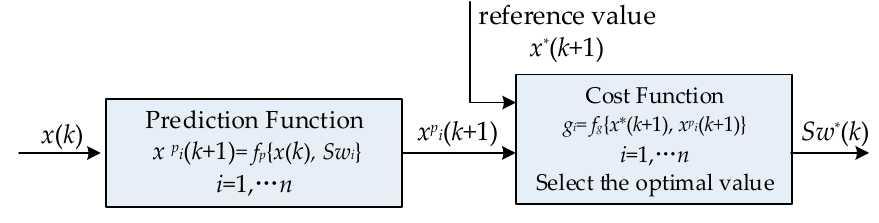
Figure 4. The basic principle of model predictive control (MPC).